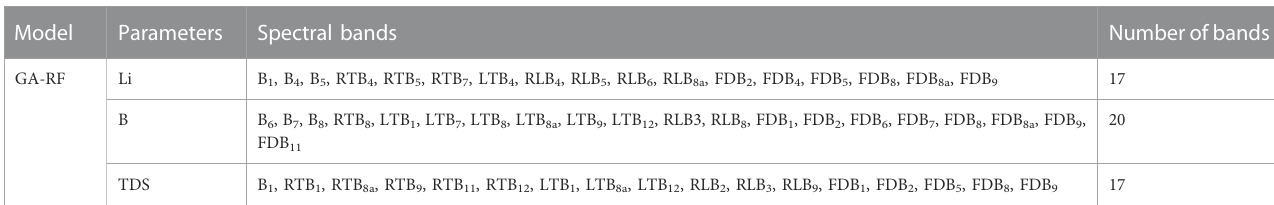
TABLE 4 Spectral feature bands of GA-RF model obtained by